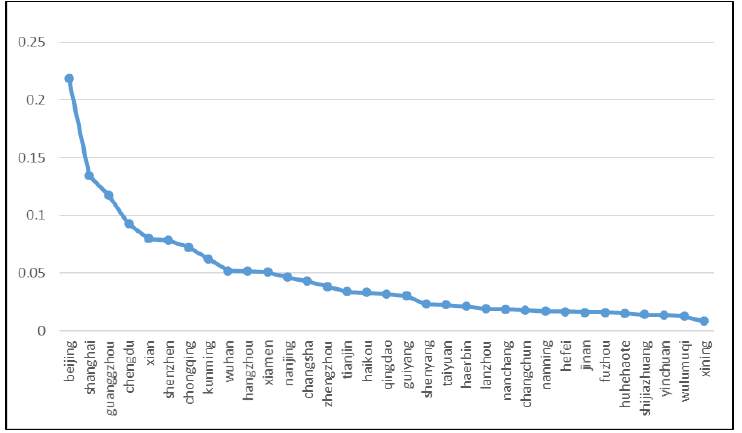
Figure 2. The indirect effect of per capita GDP on passenger traffic in different regions .